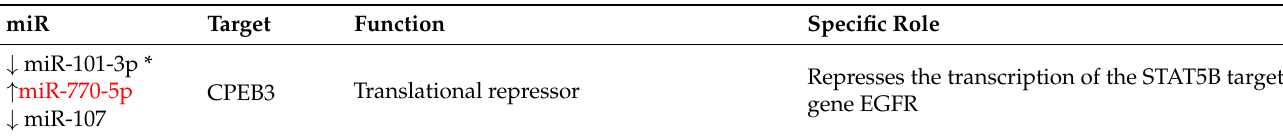
Table 3. A scheme of the relations between miRNAs and targets genes with an impact on cancer. Here are reported the only validated genes targeted by more than one miRNA. (*) Already present in GFD-responsive. In Red, the best candidates as markers of RCD2 trait. Up-arrows indicate an increase and down-arrows indicate a decrease of the miRNA in